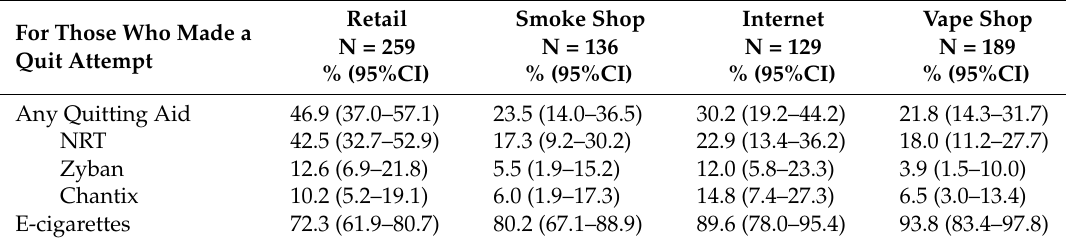
Table 3. Use of FDA-approved quitting aids or E-cigarettes in the last quit attempt, among those who smoked 12 months ago.